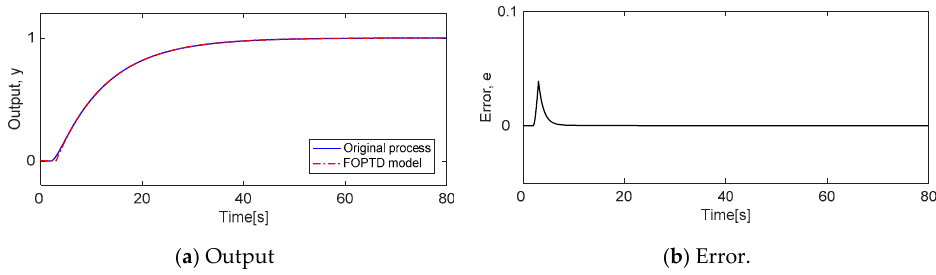
Figure 5. Verification of the approximated model.